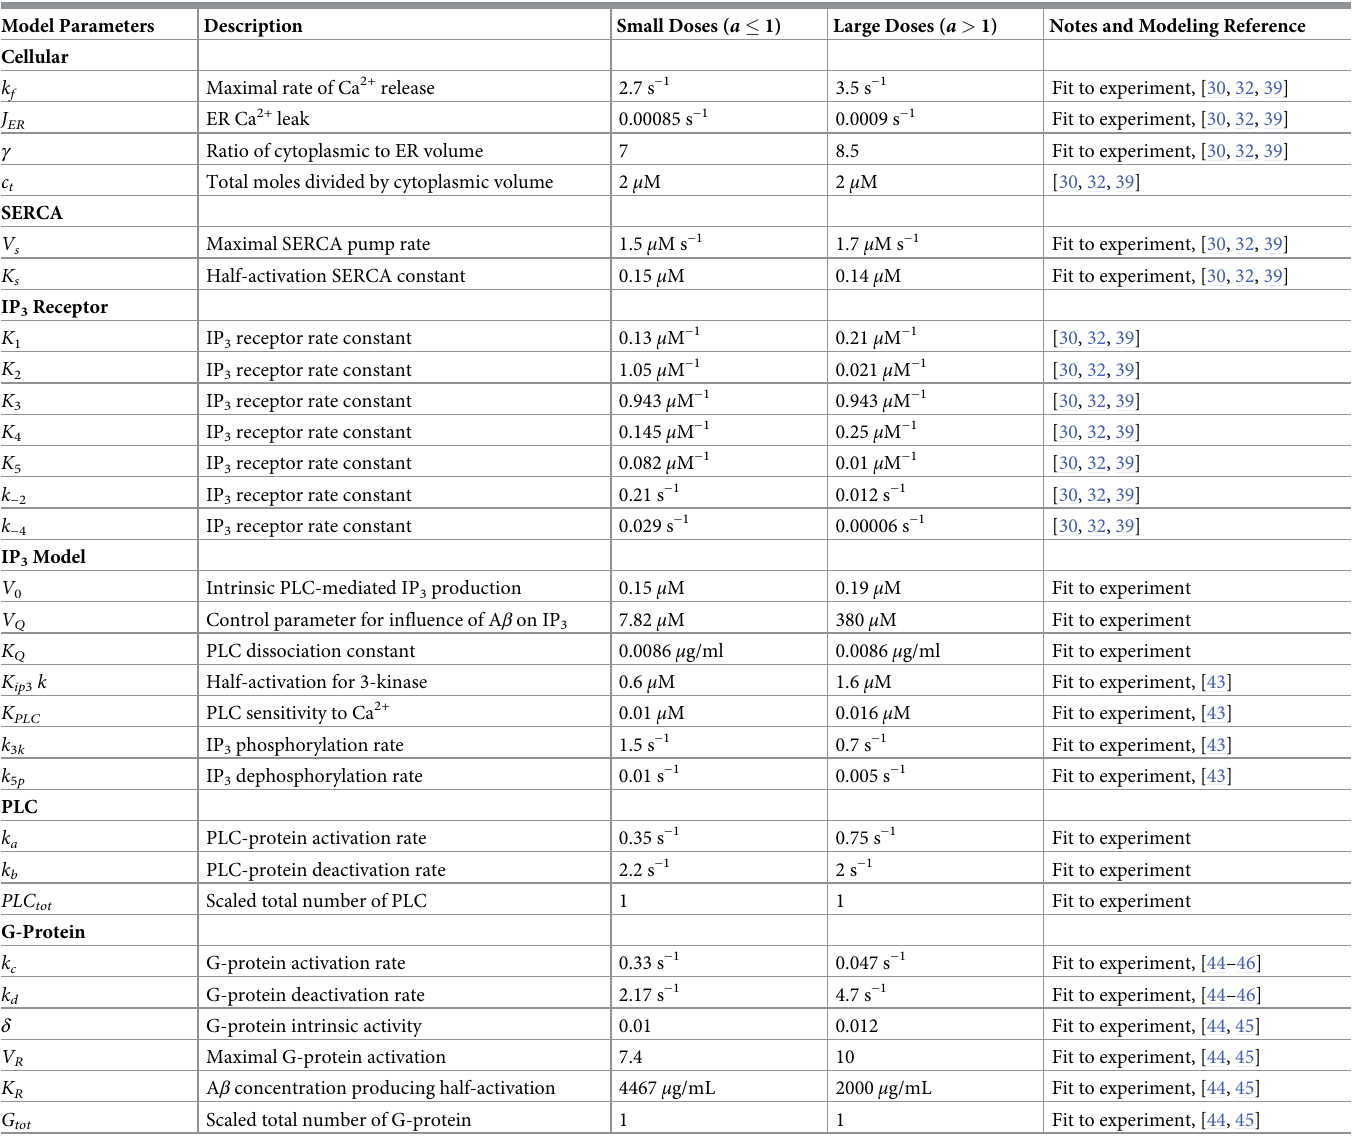
Table 2. Parameter values of the closed-cell Ca 2+